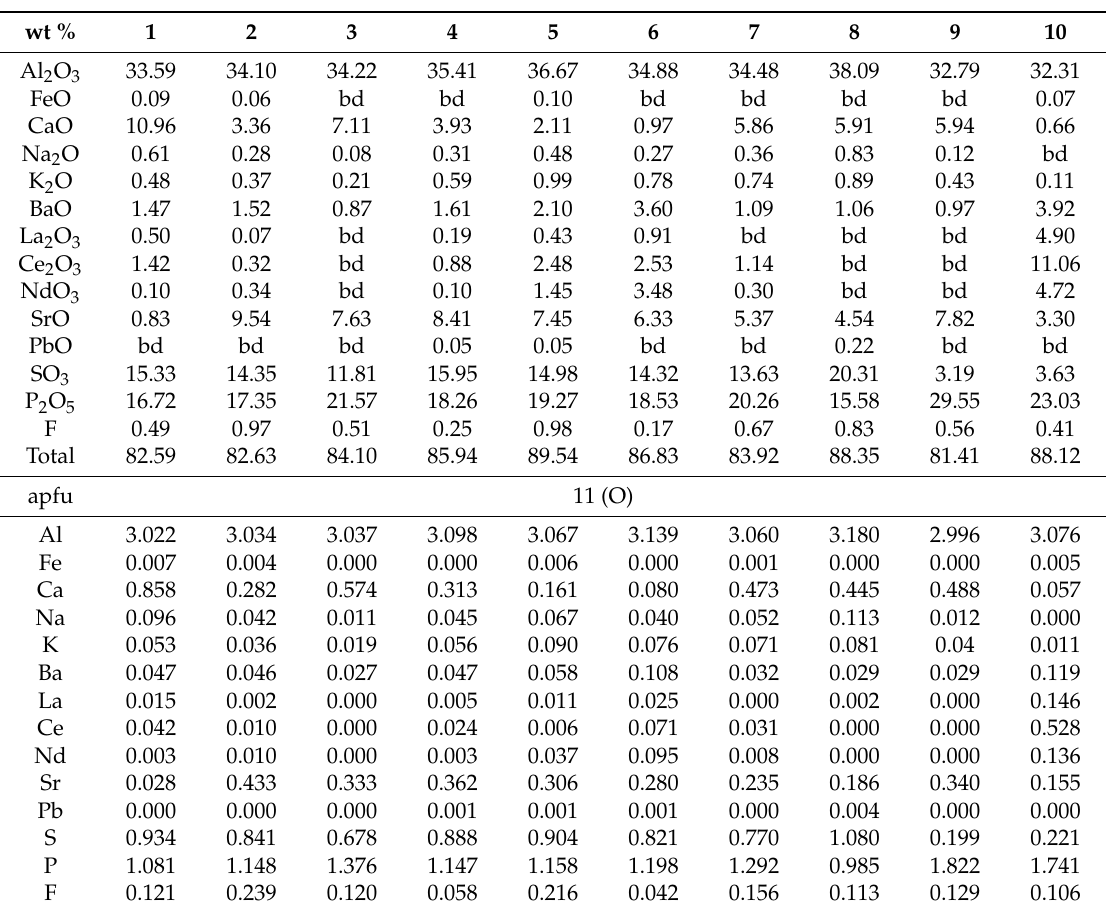
Table 2. Representative EPMA data of APS minerals from the advanced argillic alteration